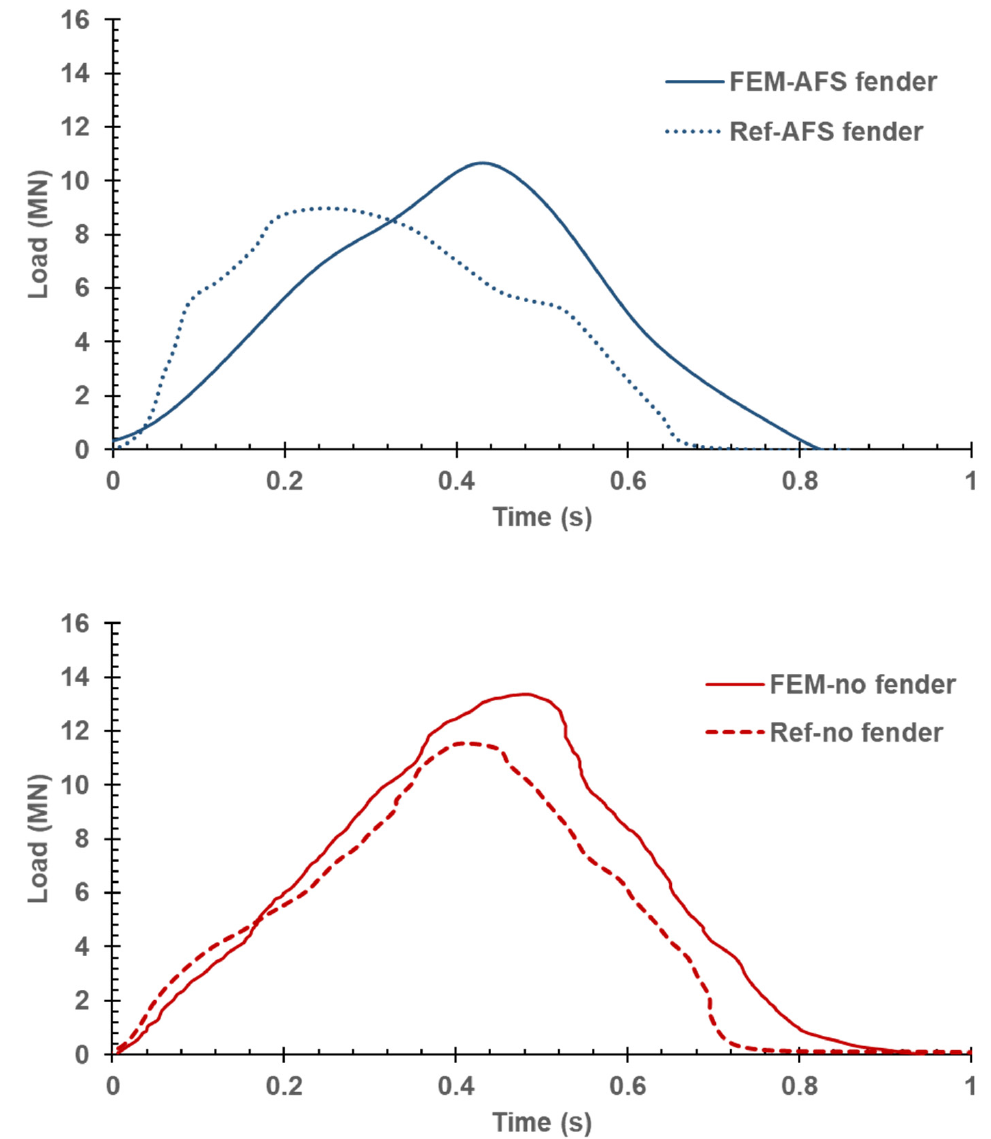
Figure 13. Load-time of the single impact collision and comparison with [19] of the OWT with and without AFS fender.